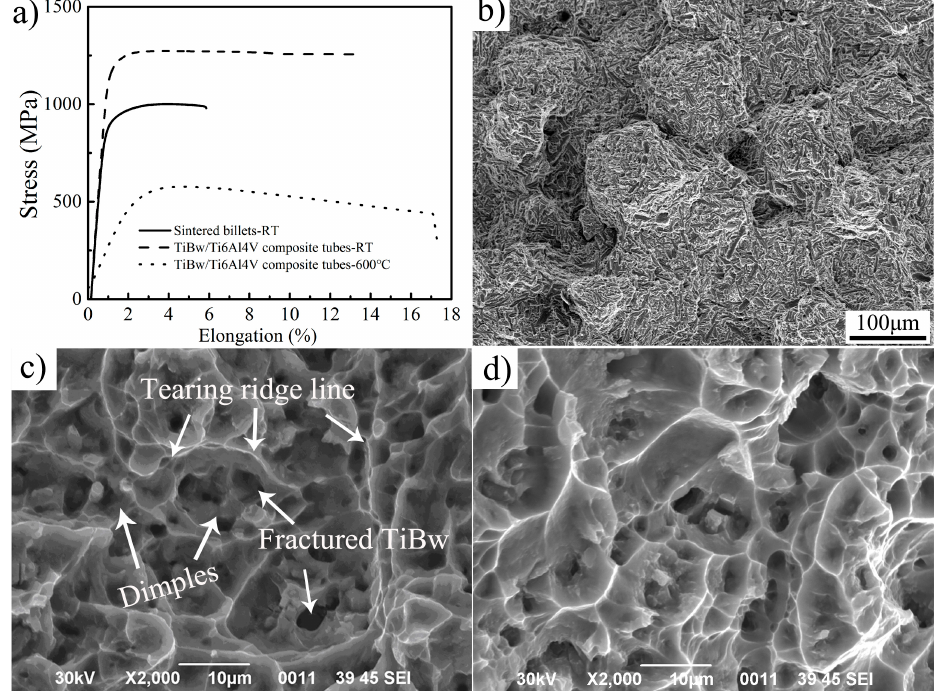
Figure 10. The tensile curves and fracture morphology of the TiBw/Ti6Al4V composite tubes: ( a ) Tensile curves at different conditions; ( b ) Fracture morphology of sintered billets at room temperature; ( c ) Fracture morphology of composite tube at room temperature; ( d ) Fracture morphology of composite tube at 600 °C.